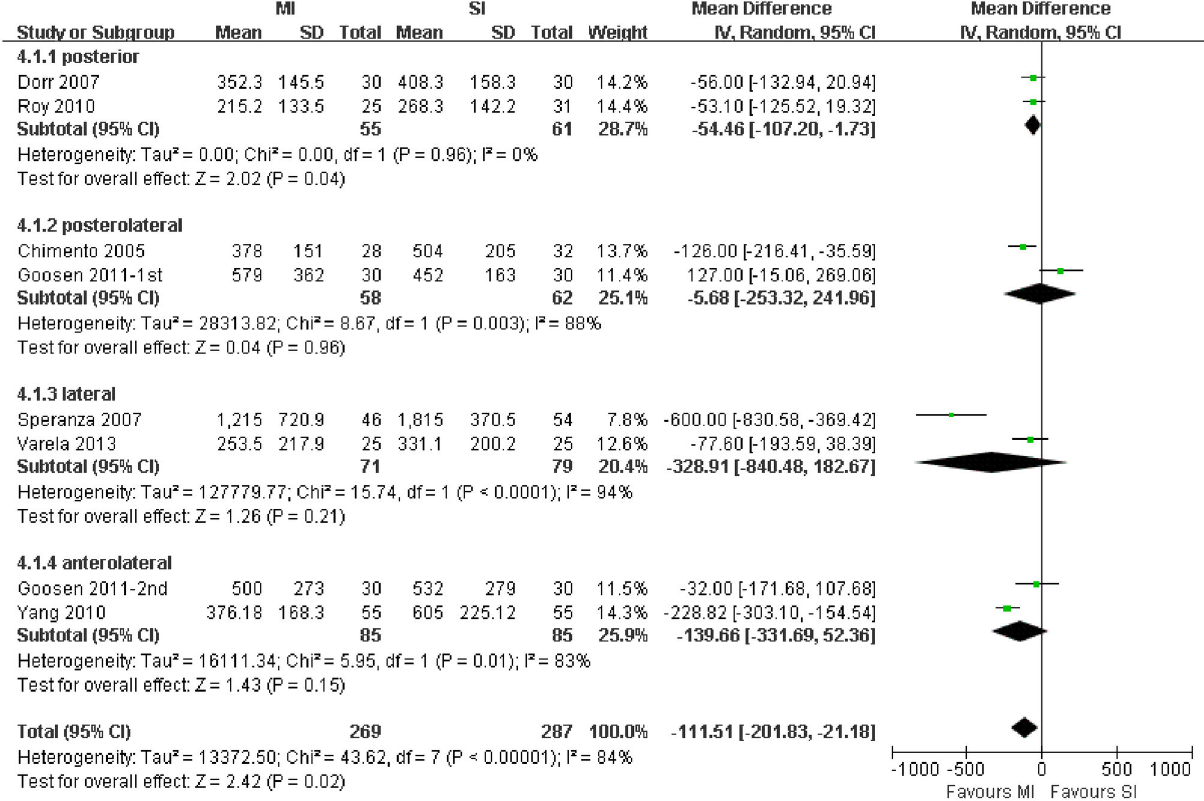
Figure 4. Meta-analysis of randomized controlled trials evaluating blood